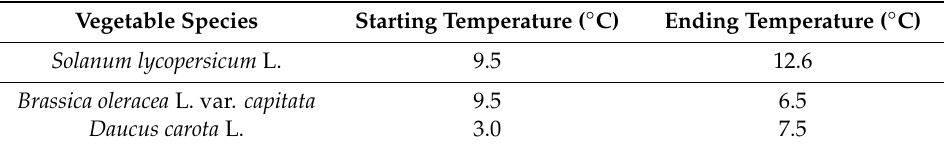
Table 1. Air temperatures delineating the beginning and end of the crop vegetation period